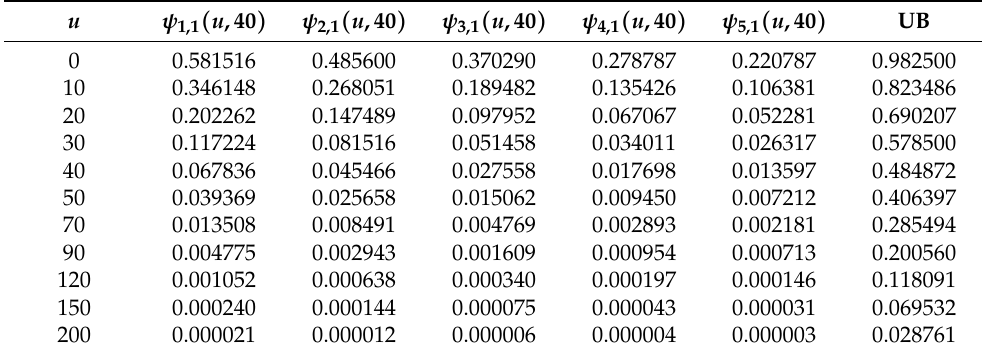
Table 1. ψ i ,1 ( u ,40 ) values with upper bounds